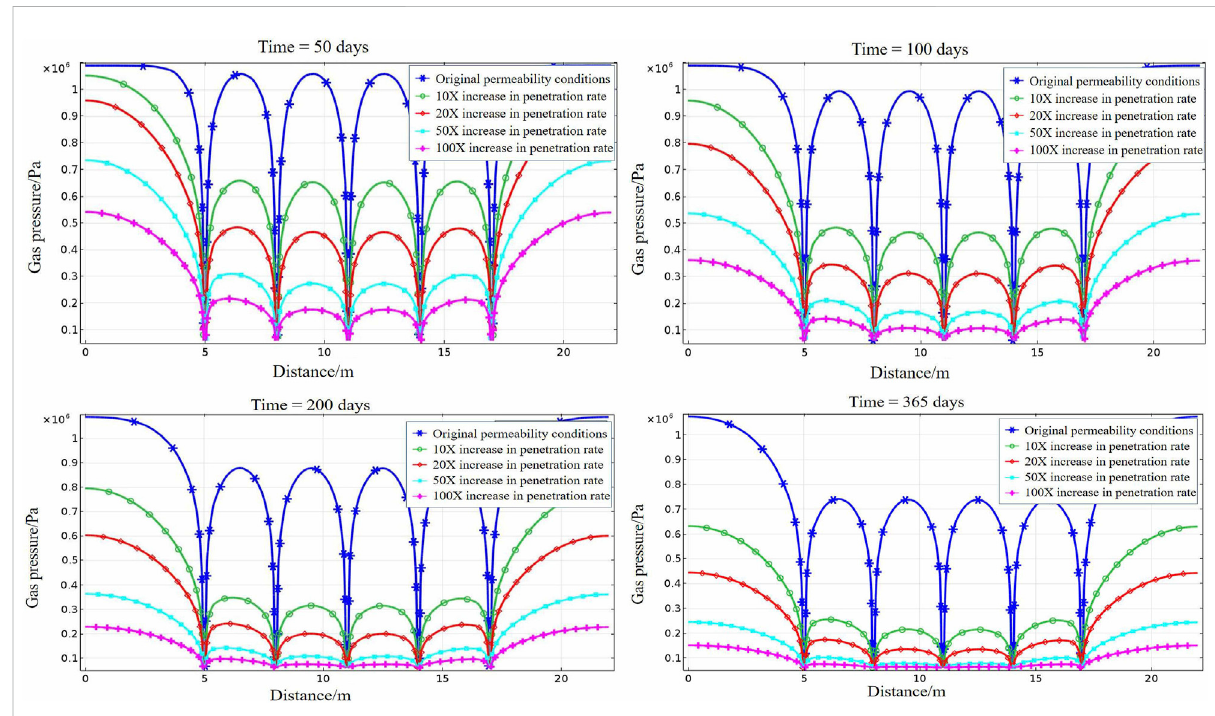
FIGURE 6 Gas extraction effect curve of different permeability increase times under different extraction times.